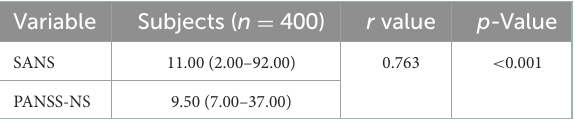
TABLE 3 Concurrent validity with Spearman correlation between SANS and